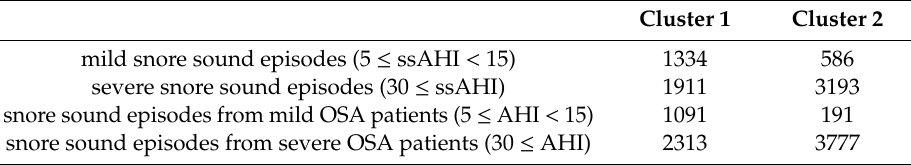
Table 7. The results of clustering mild and severe snore sound episodes with the MFCC and VI. The results of clustering mild obstructive sleep apnoea (OSA) patients and severe OSA patients with the VI. (MFCC, Mel frequency cepstral coe ffi cients; VI, volume